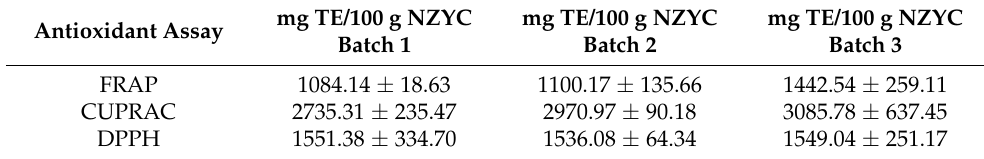
Table 5. Antioxidant activity of NZYC measured in Trolox equivalents (TE) ( n = 9). Antioxidant